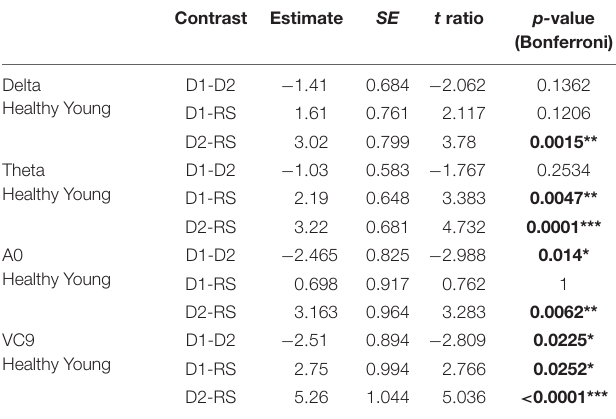
TABLE 8 | Estimate, SE, t and p- values of the post hoc comparisons for significant main effects of task in the sub GLMM conducted on healthy young